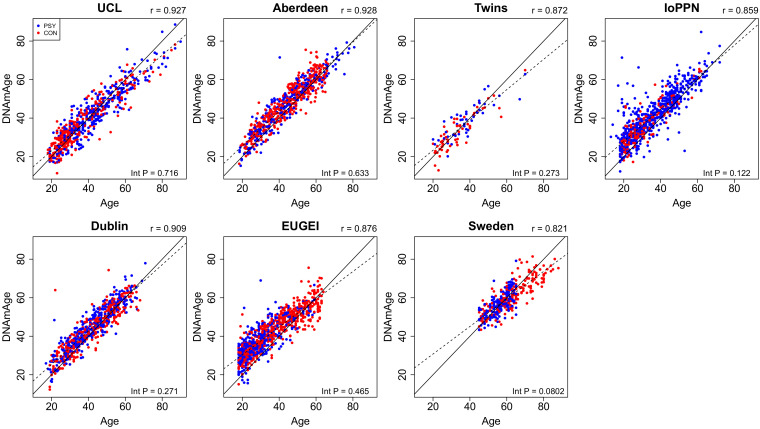
Scatterplots of DNAmAge derived from the DNA methylation data against actual chronological age for each of the cohorts.DNAmAge was calculated using the algorithm described by Horvath, 2013. Each point represents an individual and is colored by psychosis status (blue = psychosis, red = control). The solid diagonal line depicts x=y, that is, where the estimated and actual values are the same. The dashed diagonal line depicts the line of best fit. Presented at the top of the graph is the Pearson’s correlation coefficient (r) between the estimated and actual age across all samples in that cohort. Also shown in the bottom right-hand corner of each panel is an interaction p-value from a test for different correlations between DNAmAge and actual age between psychosis cases and controls.